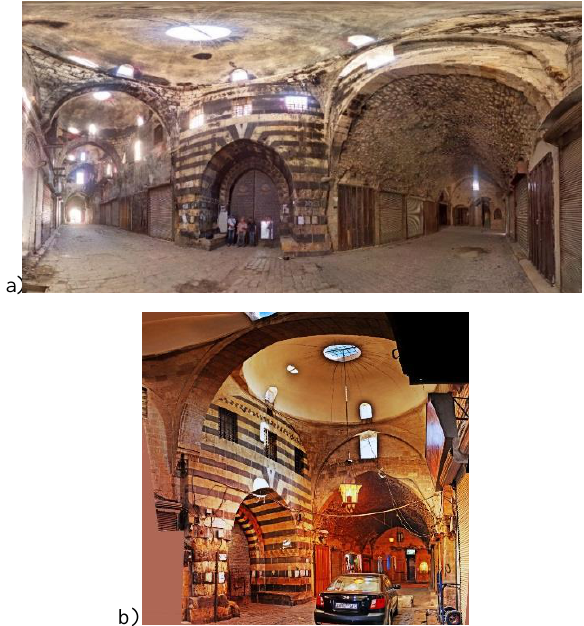
Figure 1. The old souq, current situation (a) and how it was in 2010 (b).